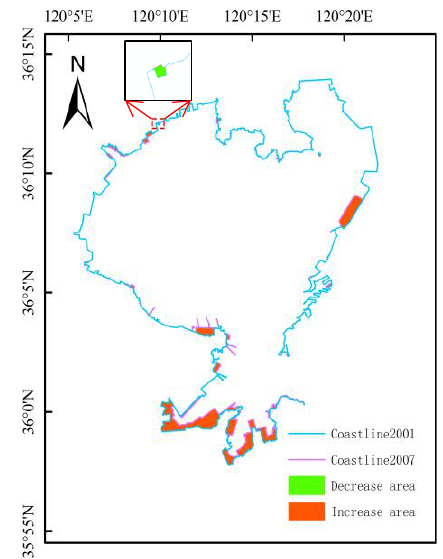
Figure 4 Increase and Decrease in Jiaozhou Bay